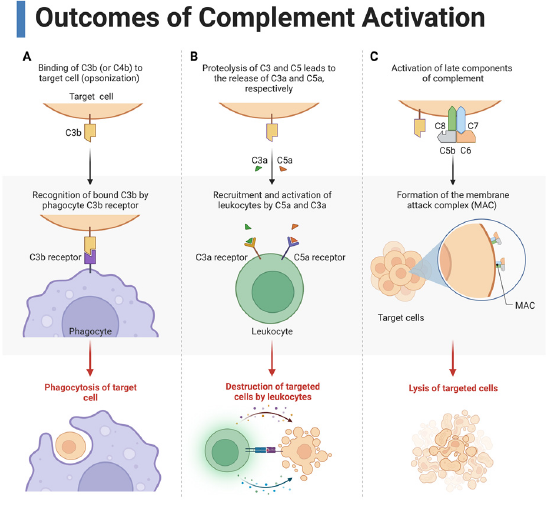
Figure 3. Three main outcomes of complement activation. ( A ) Complement cleavage products such as C3b opsonize the target cells, which allows for recognition by phagocytes for phagocytosis. ( B ) Cleavage of C3 and C5 form the anaphylatoxins C3a and C5a, respectively, which recruit and activate immune cells by binding to their receptors on leukocytes. ( C ) Late complement components C5, C6, C7, C8, and C9 form the membrane attack complex (MAC), a pore that causes cytolysis. This figure was created with BioRender, accessed on 1 December